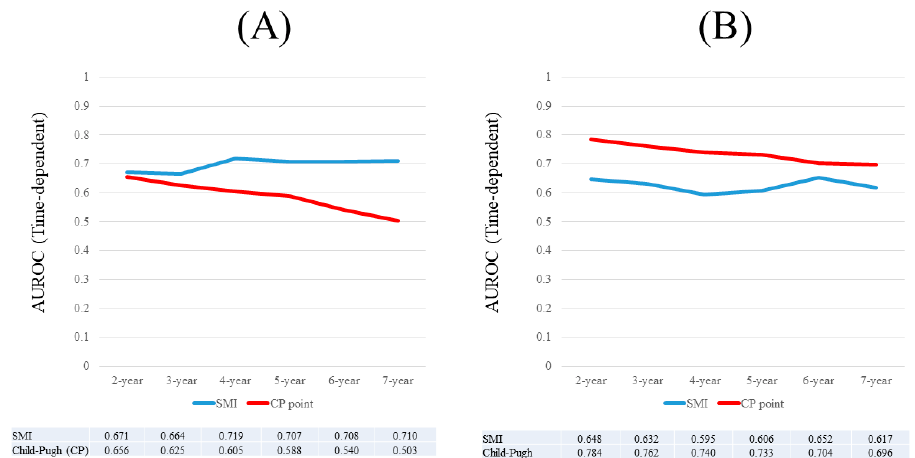
Figure 4. ( A ) Results for time-dependent ROC analyses at two-, three, four-, five-, six-, and seven- years of SMI and Child-Pugh scores for males; ( B ) Results for time-dependent ROC analyses at two-, three-, four-, five-, six-, and seven-years of SMI and Child-Pugh scores for females. ROC; receiver operating characteristics, AUROC; area under the ROC, SMI; skeletal muscle mass index, CP; Child- Pugh.